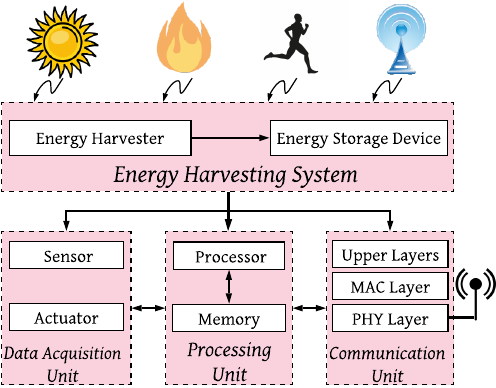
Figure 1. General schematic of an IoT node equipped with energy